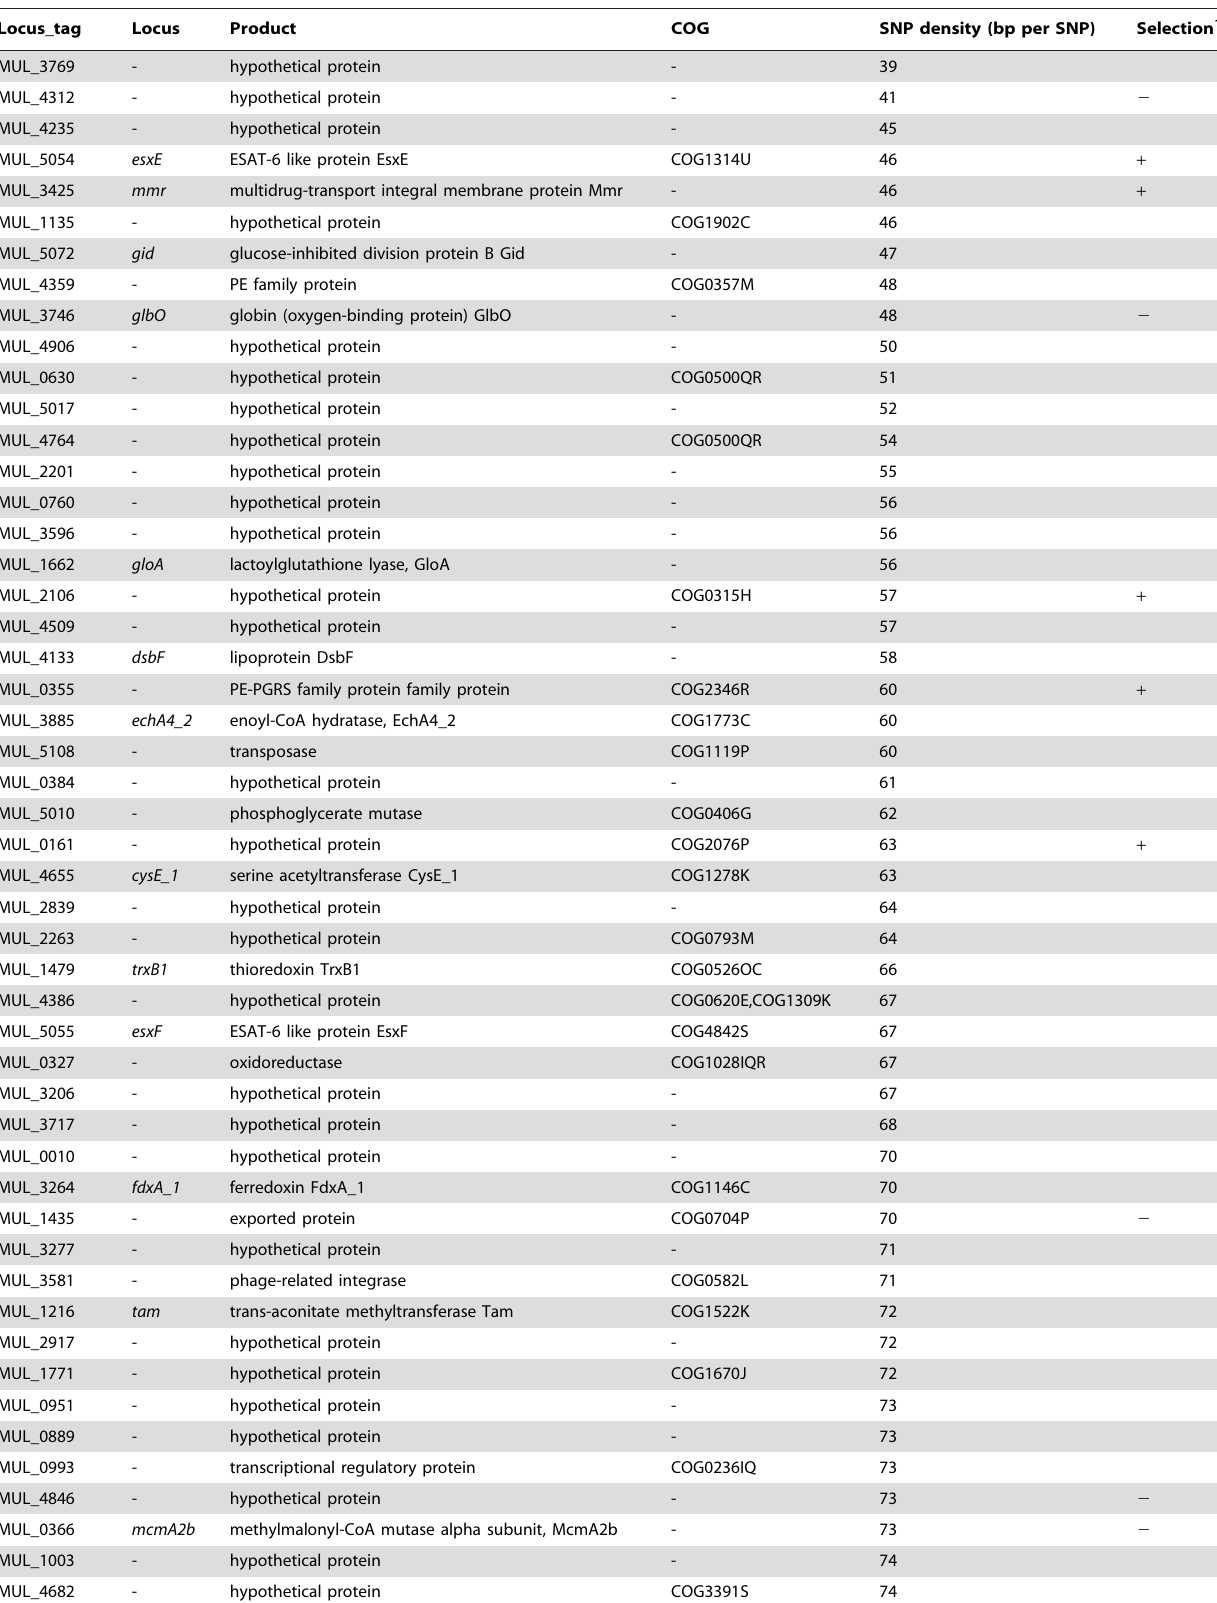
Table 3. Genes potentially under selection ordered by SNP